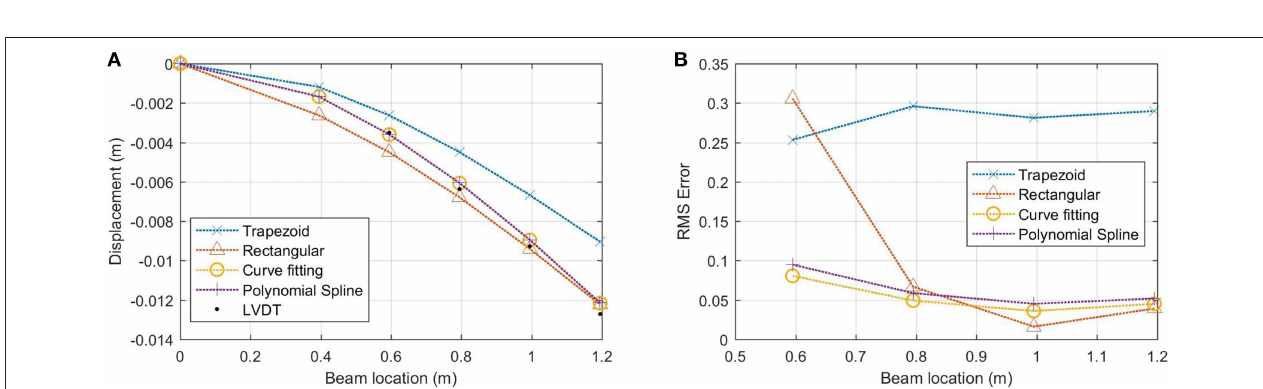
FIGURE 10 | Cantilever beam static load tests with 16.35 N point load at the free end (A) displacement from FBG and LVDT sensors, and (B) RMS error of strain based displacement estimations at each sensor location.